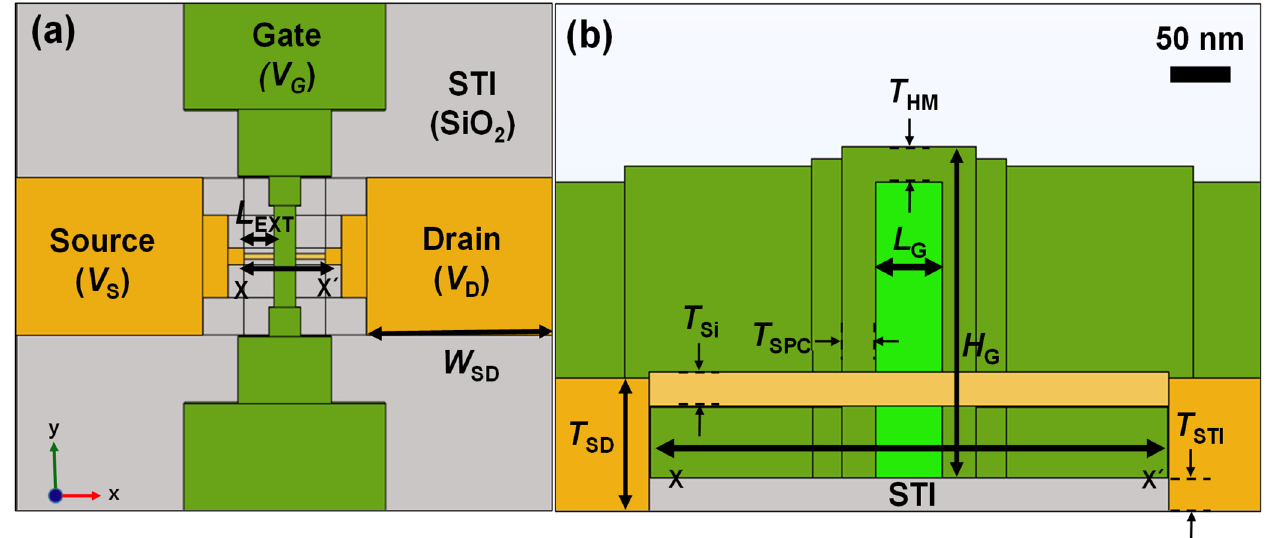
Figure 2. Schematic of the device used for simulations. ( a ) Top-view image of the GAA FET. ( b ) Cross- sectional image of the GAA FET cut along the x–x (cid:48)